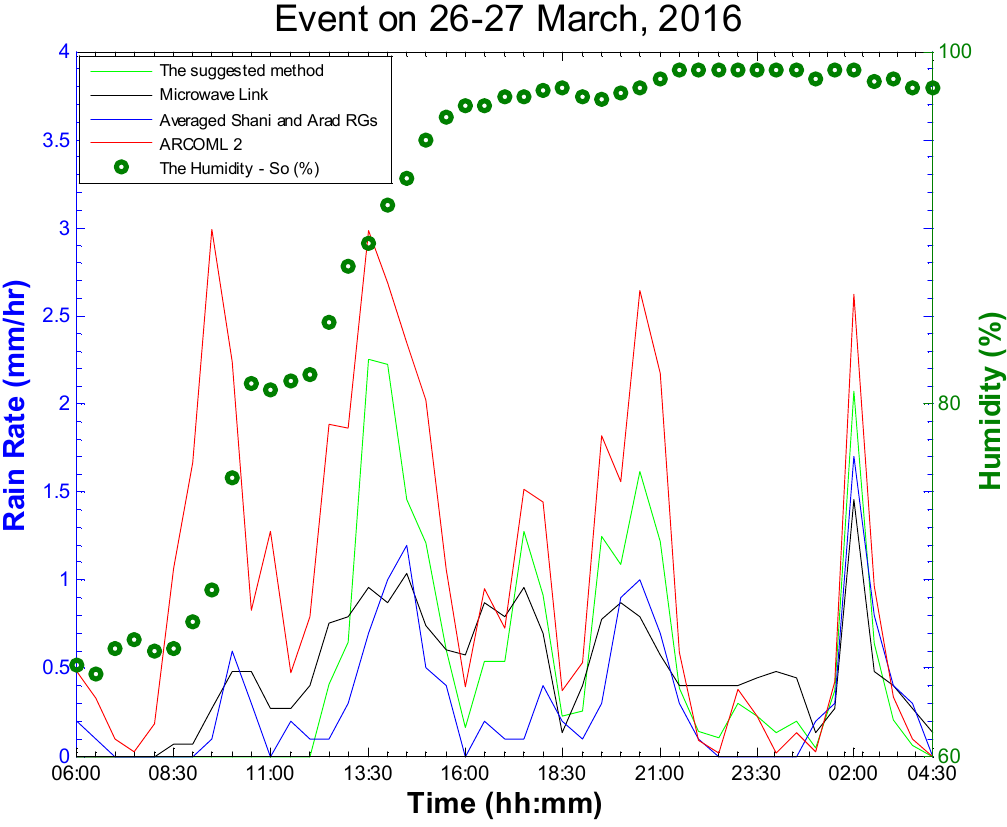
Figure 6. The temporal rain rate according to the average of Arad and Shani RGs (in blue), the rain rate according to the microwave link (in black), the lower weather radar beam (ARCOML 2, in red), as well as according to the suggested method (in green) in correspondence with the event’s relative humidity averaged from the measurements at the weather station in Arad and Shani, over 20 h on 26–27 March at southern Israel.